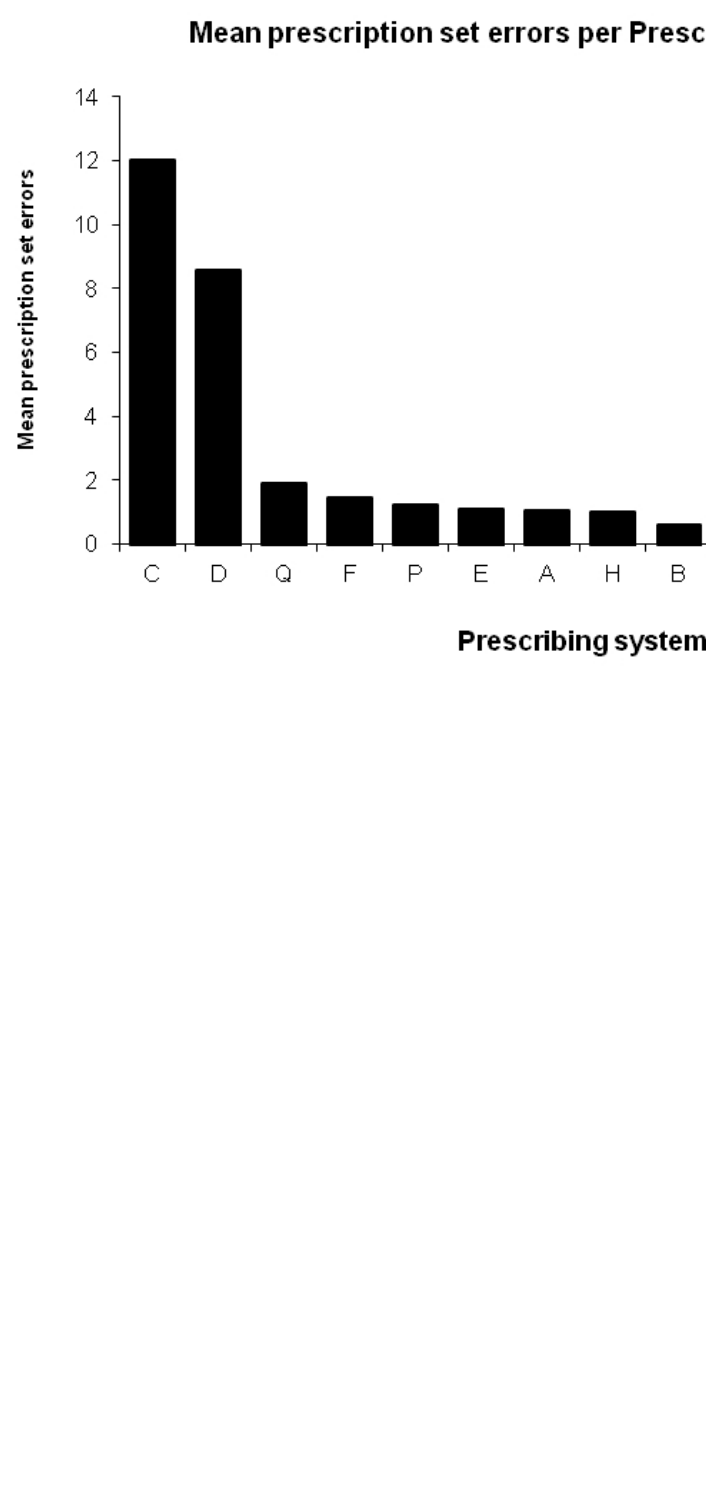
Figure 7. Mean prescription set errors (post-NEF) per Prescribing